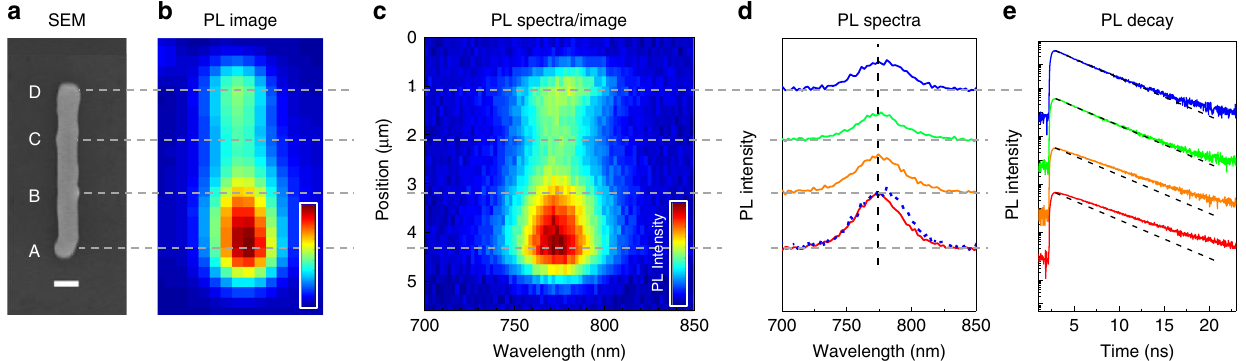
Fig. 2 Spatially resolved PL spectra and PL decay kinetics of the nanowire NW#1 at 298 K. a SEM image; the scale bar is 500 nm. b Luminescence image . c PL emission intensity as a function of wavelength and the emission position along the nanowire axis. d The PL spectra collected from the regions marked by the horizontal lines A – D, spectrum of region D was scaled and overlaid with the spectrum of region A ( dashed line ) to show the spectral shift and broadening. e Time-resolved PL decay pro fi les collected from the same regions of NW#1; the dashed lines are the guides showing an exponential decay with the lifetime of 2.5 ns. Horizontal dashed lines are eye guides to mark the regions of the nanowire where the particular properties were measured